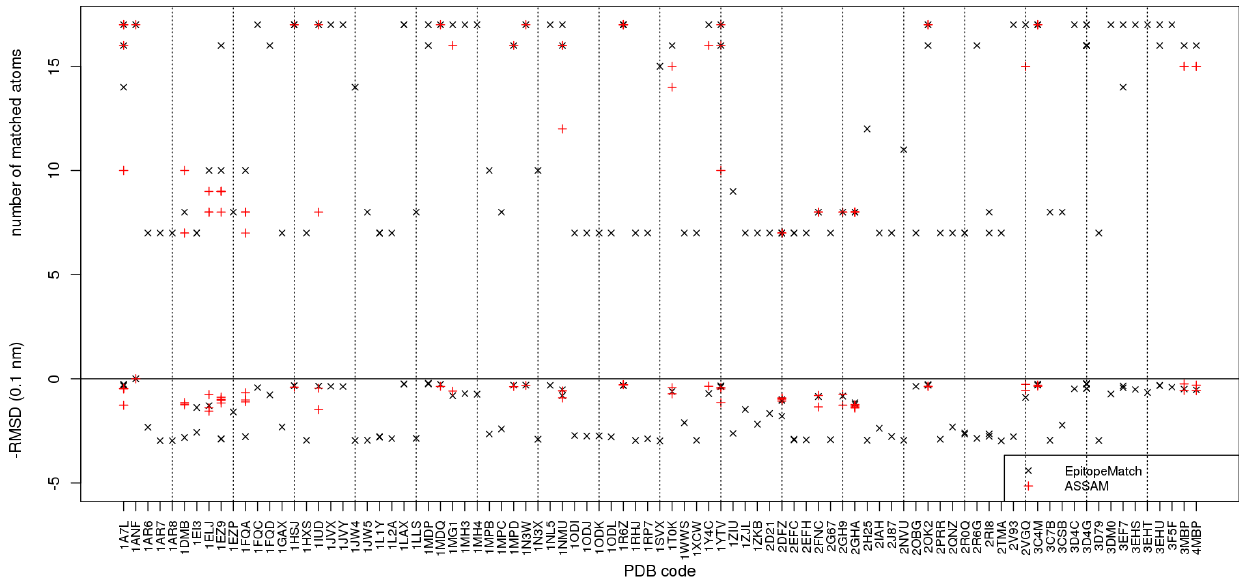
Figure 9. Comparison of E PITOPE M ATCH (black crosses) with A SSAM [9] (red crosses), with a PDB-wide search for epitopes similar to the maltose binding pocket in 1ANF formed by 17 atoms. Along the horizontal axis the names of the PDB structures in which MCS have been identified are given. The vertical axis gives above the zero line the number of matched atoms, below zero the corresponding